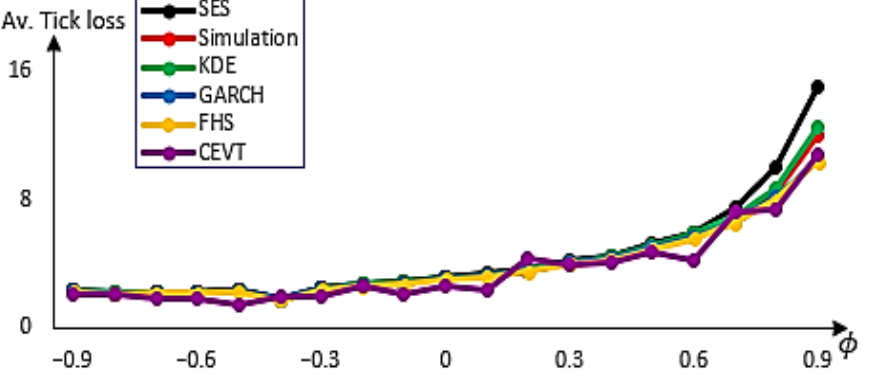
Figure 6. Average tick loss values for lead times of four weeks and when forecasting errors follow a gamma distribution.